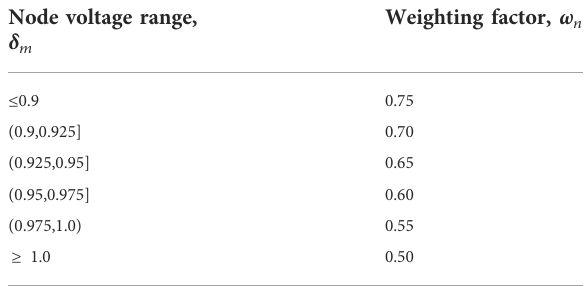
TABLE 1 Weight molecules corresponding to different voltage